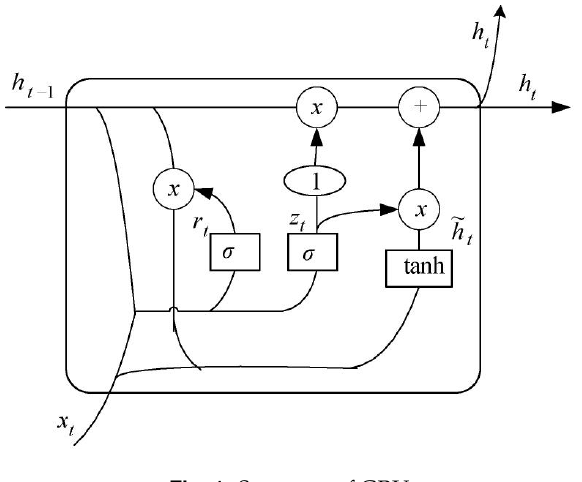
Fig. 1. Structure of